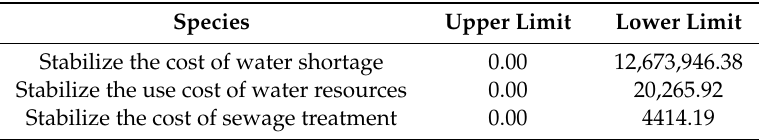
Table 5. The range of robust restriction (tons /